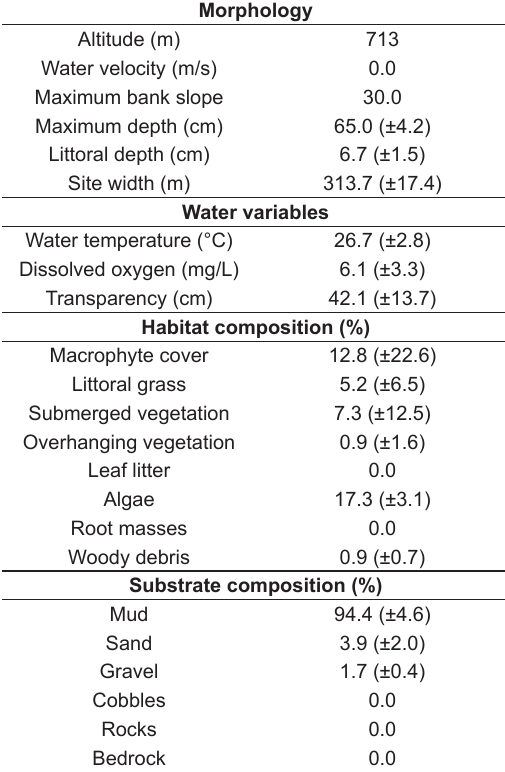
Table 2. Environmental variables (average ± SD) collected in the study site.